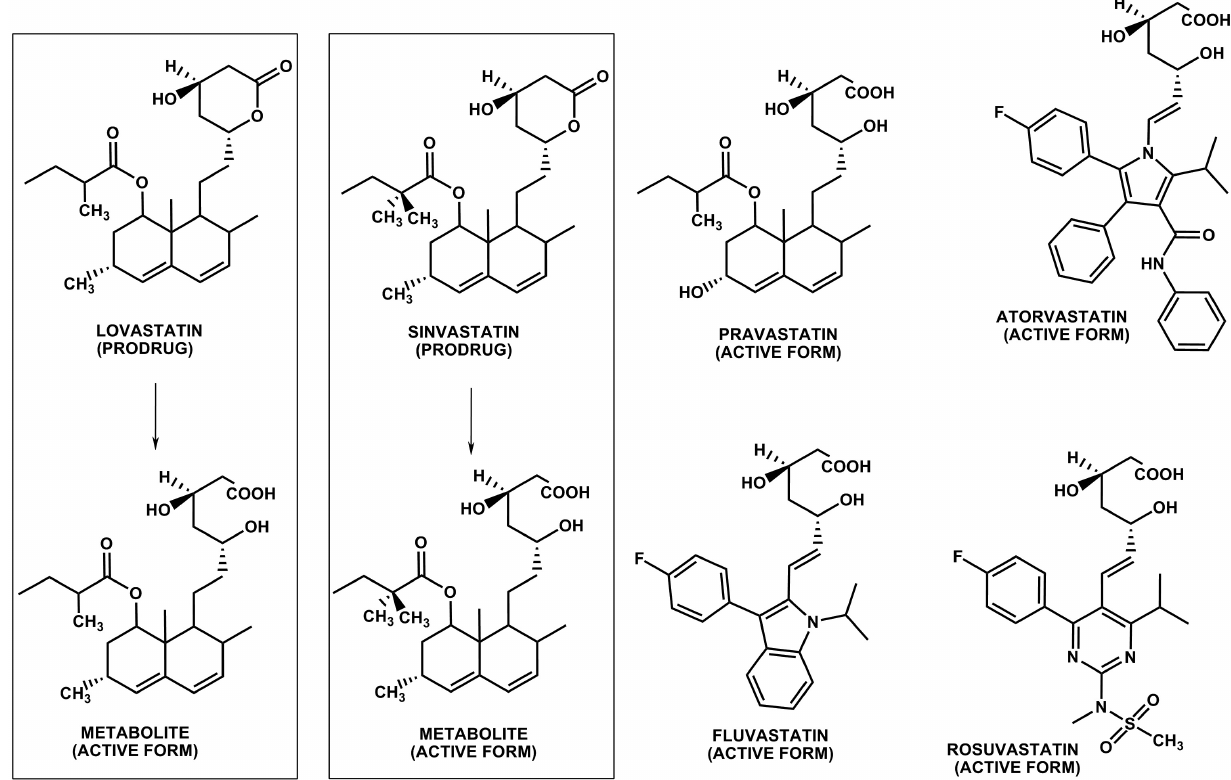
FIGURE 9 - Statins used in